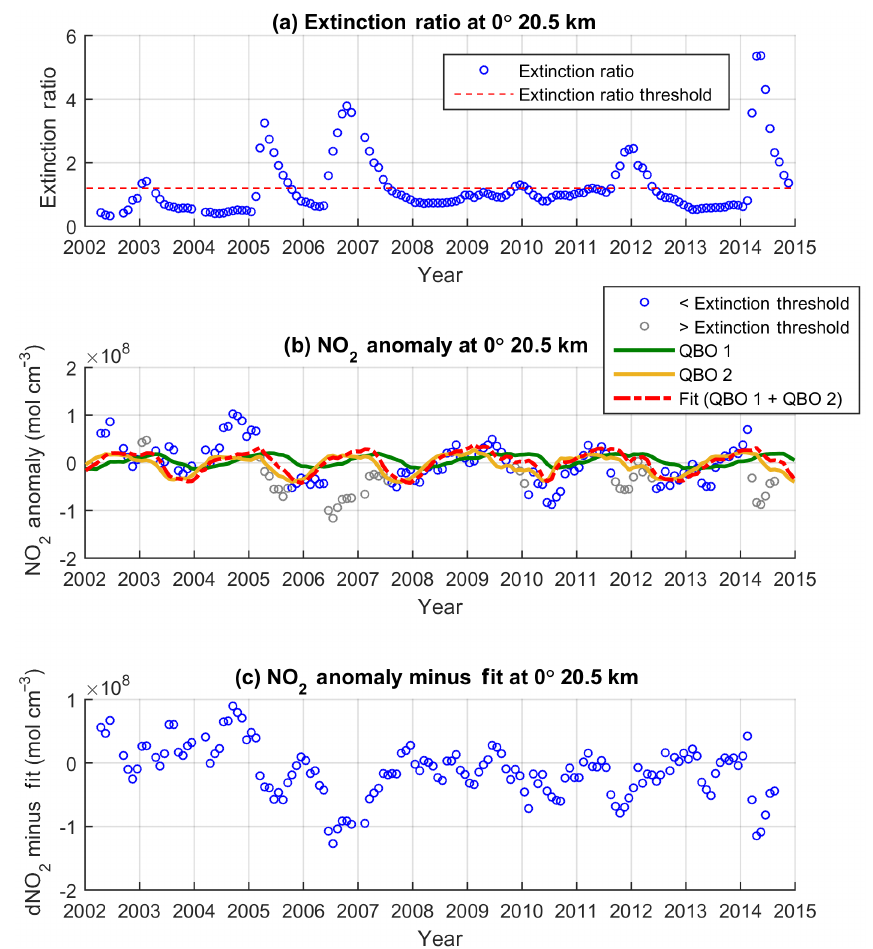
Figure 1. QBO fitting results for 0 ◦ latitude at 20.5km. (a) Extinction ratio time series (blue circles) with the extinction ratio threshold (red dashed line). (b) NO 2 anomaly time series for time periods with extinction ratios lower than the extinction ratio threshold (blue circles) and time periods with extinction ratios greater than the extinction ratio threshold (gray circles). The fits for the two QBO principal components, QBO 1 (green line) and QBO 2 (yellow line), and the total fit (red dashed lined) to the NO 2 anomaly time series during time periods with extinction ratios lower than the extinction ratio threshold are also shown. (c) NO 2 anomaly time series after subtraction of the